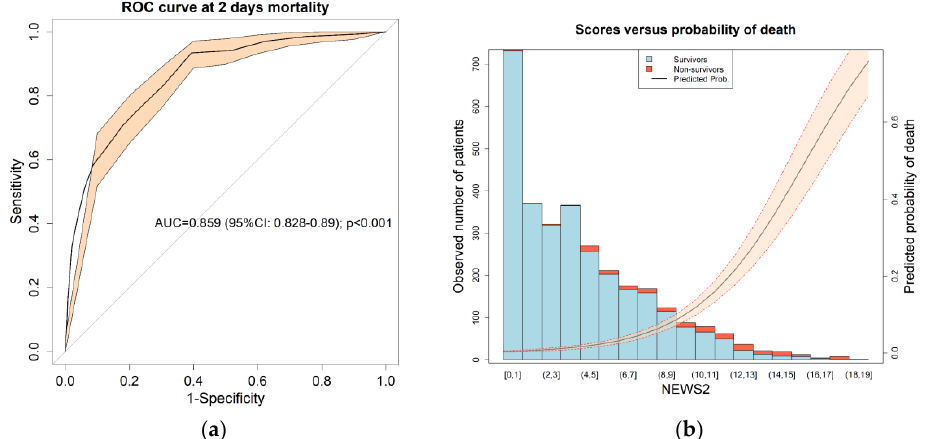
Figure 2. ( a ) Receiver operational characteristic (ROC) by NEWS2 for early mortality. The bold line shows the value of the ROC curve and the orange shading is the 95% confidence interval. In the center of the graph is the area under the curve (AUC), its 95% confidence interval and the p -value of the comparison against the null hypothesis (AUC = 0.5). ( b ) Probability of death based on the value of NEWS2 for early mortality. The bar graph shows the number of patients in the whole cohort for each scale value (survivors in blue and nonsurvivors in red). The trend line shows the estimated probability of death.